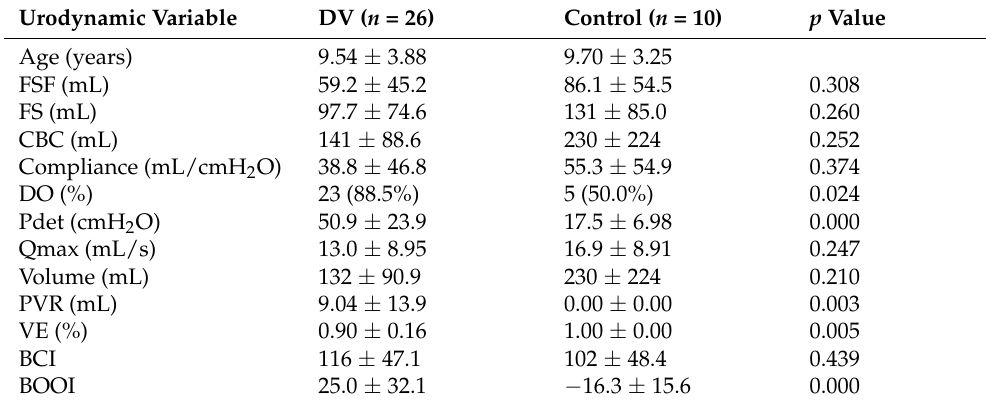
Table 2. The urodynamic parameters of 26 children with dysfunctional voiding and 10 controls.